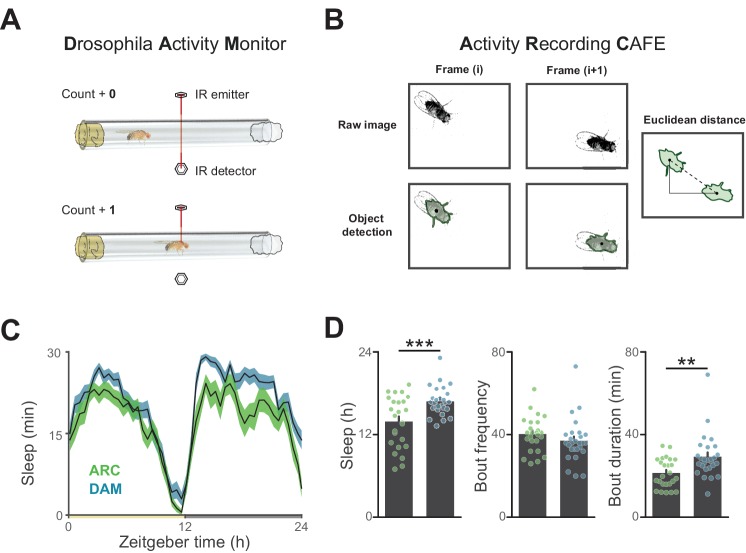
Influence of recording apparatus on sleep architecture.(A) Illustration of motion estimation using the Drosophila Activity Monitor in which the number of times a fly breaks an infrared beam in a glass tube is counted. (B) Illustration of motion quantification by first detecting an object and determining the frame-frame distance of the object centroids. (C) A comparison of circadian sleep profiles derived from the Drosophila Activity Monitor versus object tracking reveals general conservation of sleep patterning between systems. (D) Measurement of total sleep and sleep duration are lower using video tracking, indicating a higher resolution of waking motion. 25–27 flies per condition, **p<0.01, ***p<0.001, Student’s t-test.